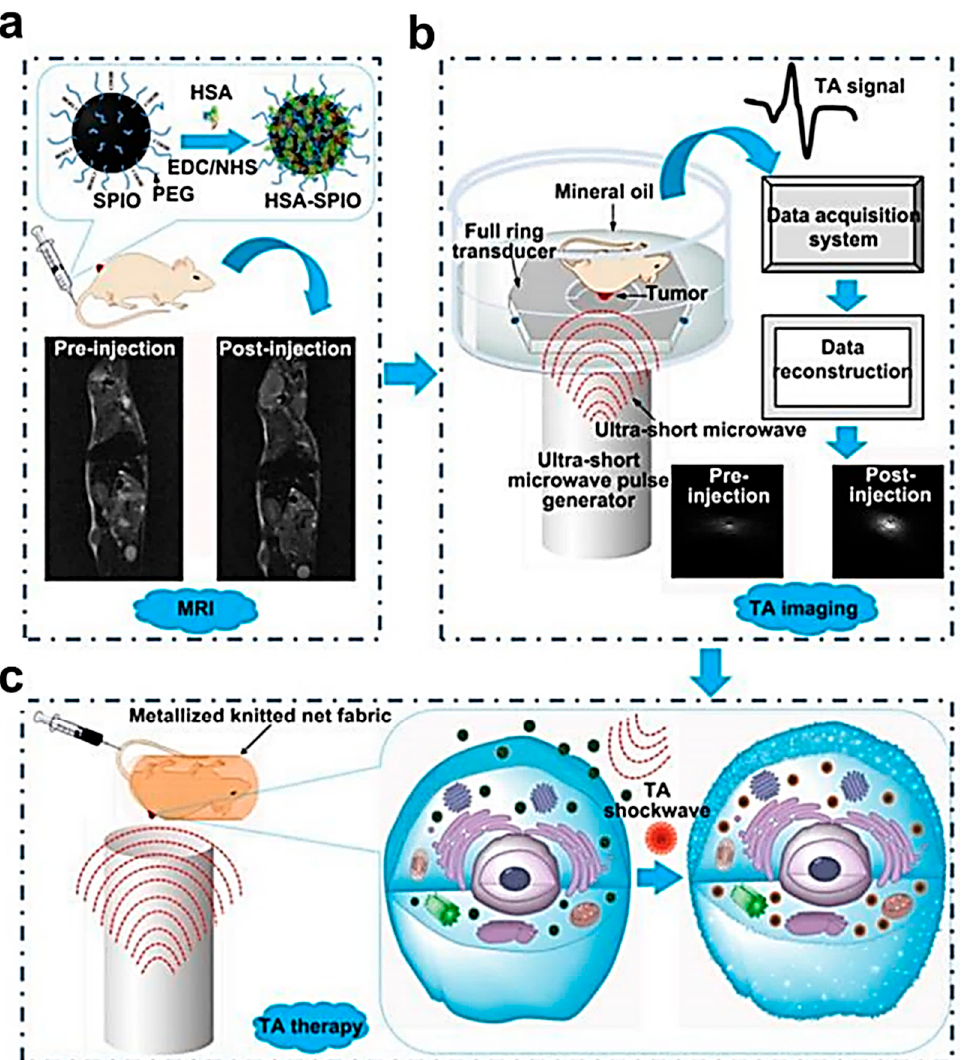
Figure 7. Schematic illustration of ( a ) the process of HSA-SPIO synthesis and intravenous injection into mice for MRI. ( b ) the TA imaging system. ( c ) HSA-SPIO as a TA therapeutic agent for tumor therapy. Reproduced with permission from [196]. Copyright Ivyspring International Publisher, 2017.